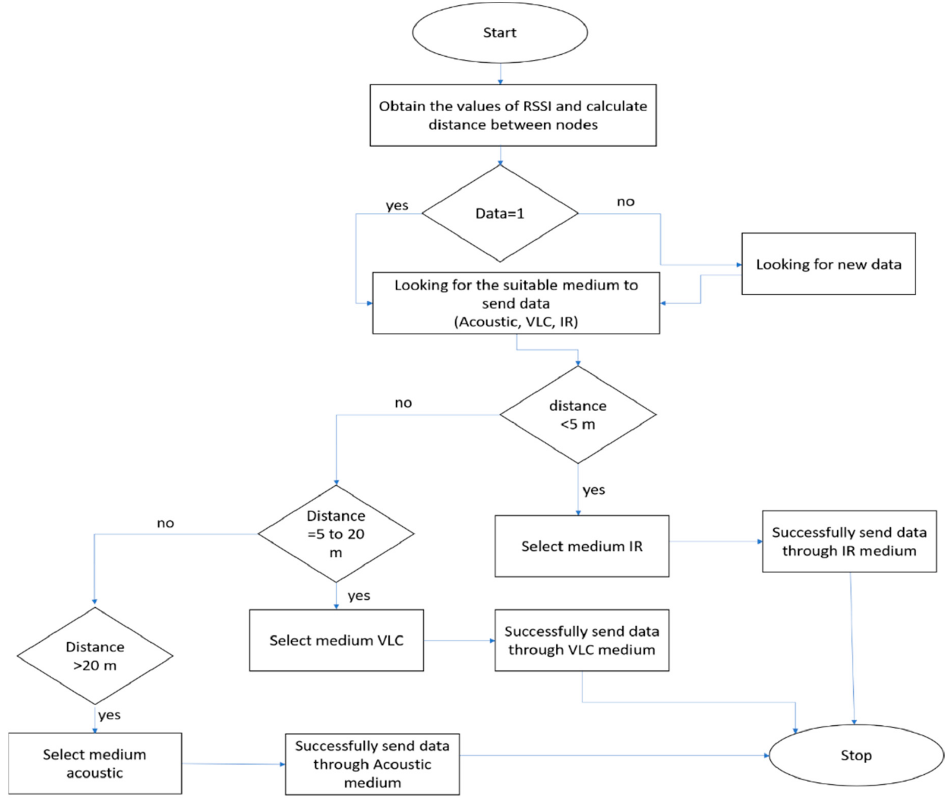
Figure 9 . Medium selection mechanism. Figure 9. Medium selection mechanism.